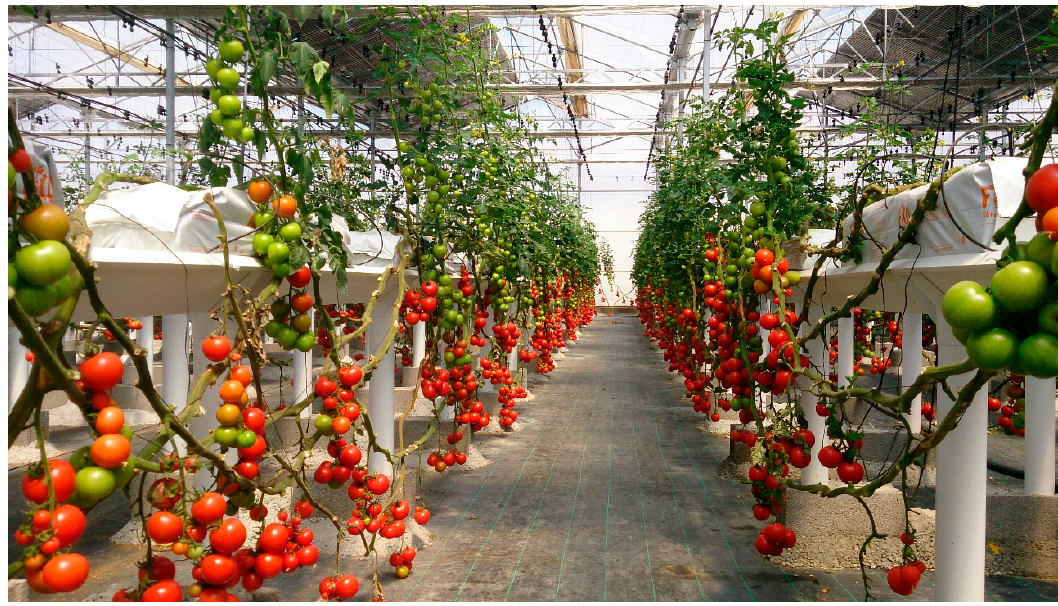
Figure 4. Detail of tomatoes planted on Coco fiber artificial substrate.